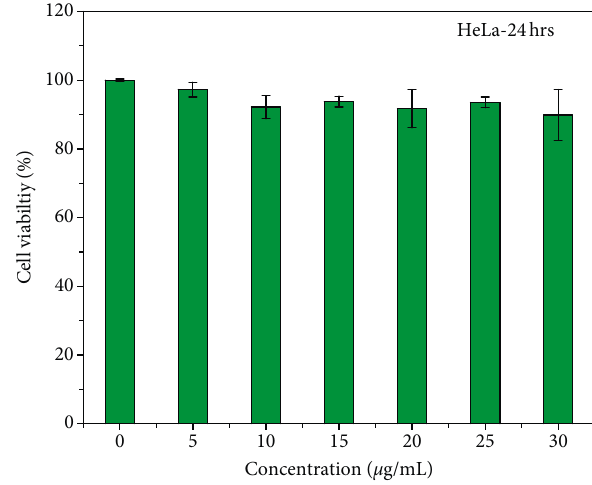
Figure 10: Cytotoxicity studies of the coumarin derivative. Figure 8: Anisotropy studies of the coumarin derivative with the